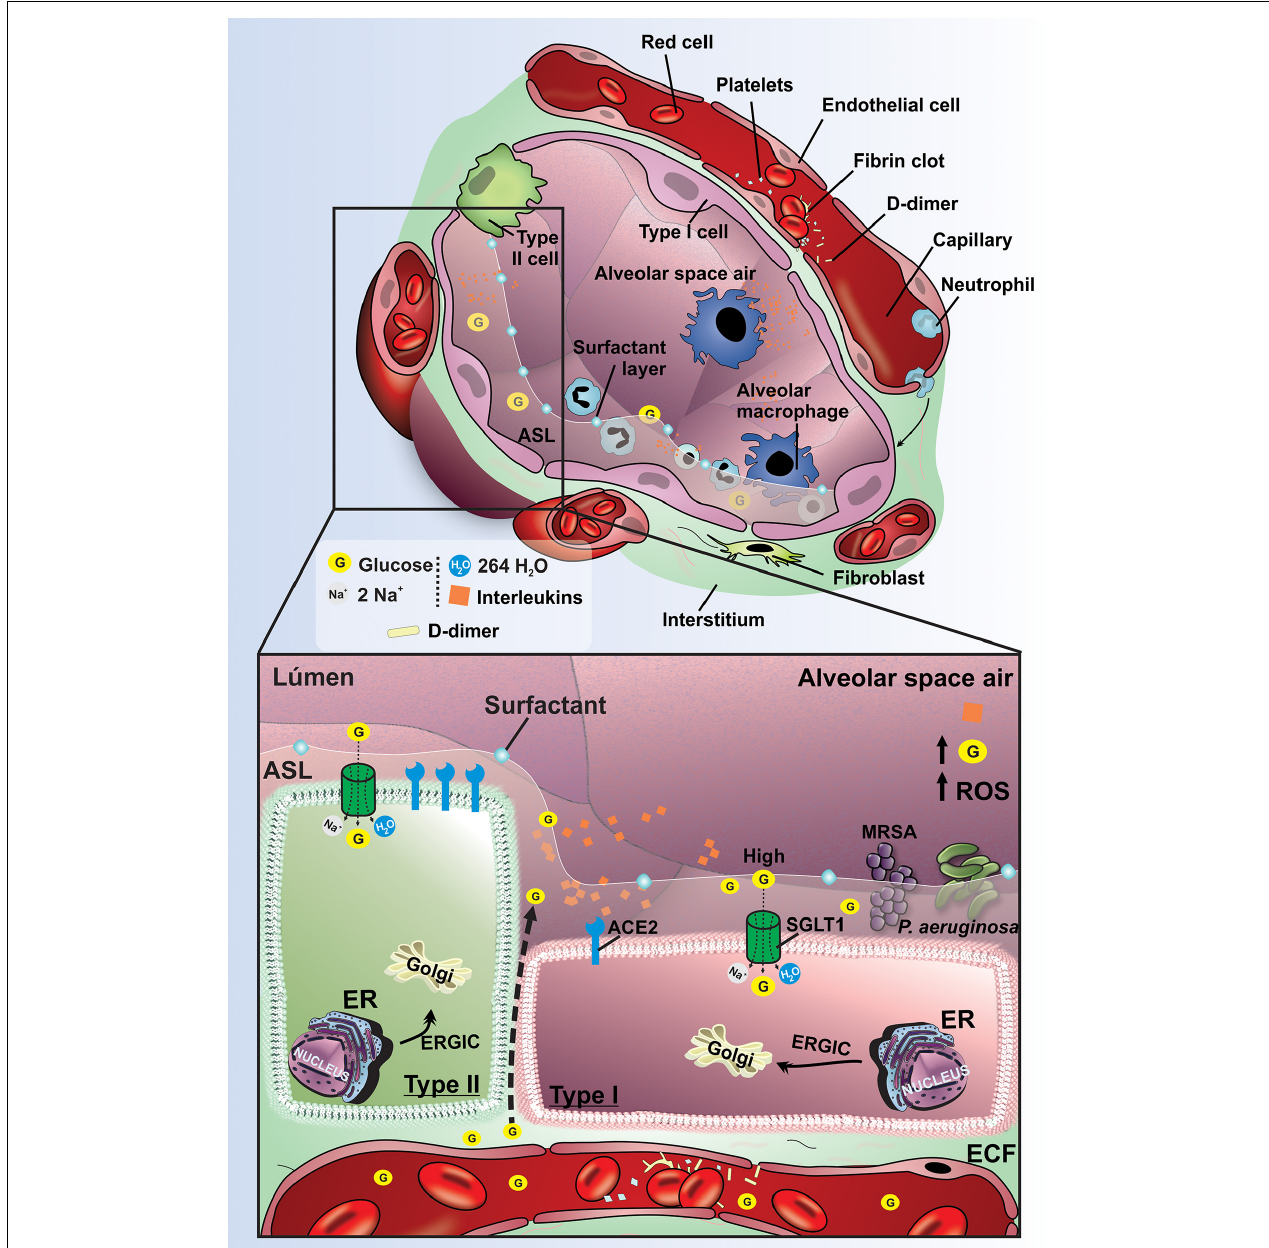
FIGURE 2 | Pathophysiological mechanisms to regulate lung function and ASL glucose concentration effects on diabetic hyperglycemic patients. Schematic representation of pathophysiological mechanisms related to DM in the lung. The high concentration of glucose and the increased volume in the ASL are maintained mainly by the low expression of SGLT1 in the apical membrane of type I and II pneumocytes in the lungs of diabetics. Hyperglycemia promotes increased paracellular glucose transport from blood to ASL. The evolution of DM promotes activation of the inflammatory cascade with the production of interleukins, increased ROS, and endothelial damage. These changes provide an increased risk for pneumonia due to the proliferation of bacteria P. aeruginosa and MRSA. G, glucose; SGLT1, Na + /glucose/H 2 O type 1 cotransporter; ECF, extracellular fluid; ER, endoplasmic reticulum; ERGIC, endoplasmic reticulum-Golgi intermediate compartment; ACE2, receptor angiotensin-converting enzyme 2; ROS, reactive oxygen species; P. aeruginosa , pseudomonas aeruginosa ; MRSA, Methicillin-resistant Staphylococcus aureus ; Orange rhombus: